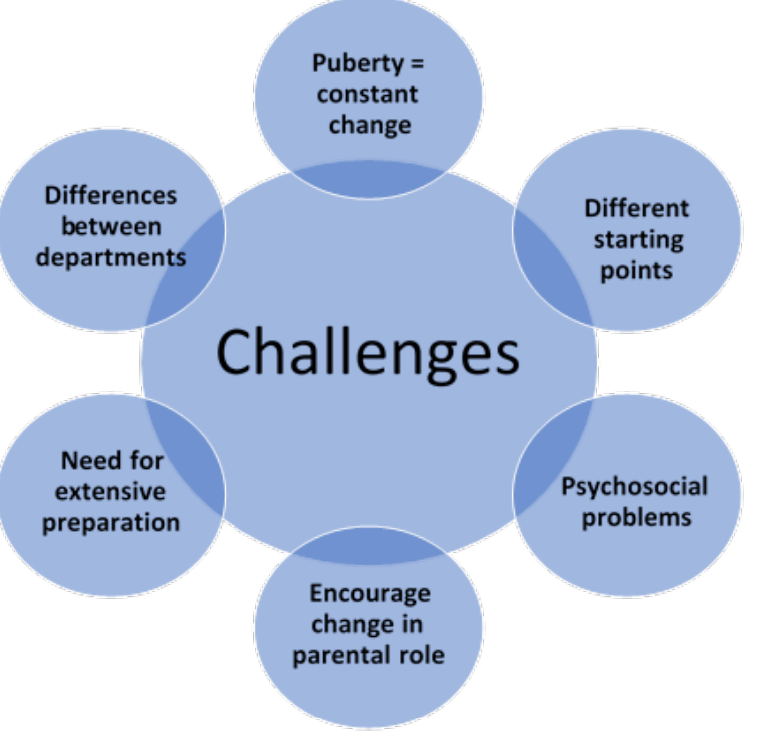
Figure 2. Challenges of the transition process.